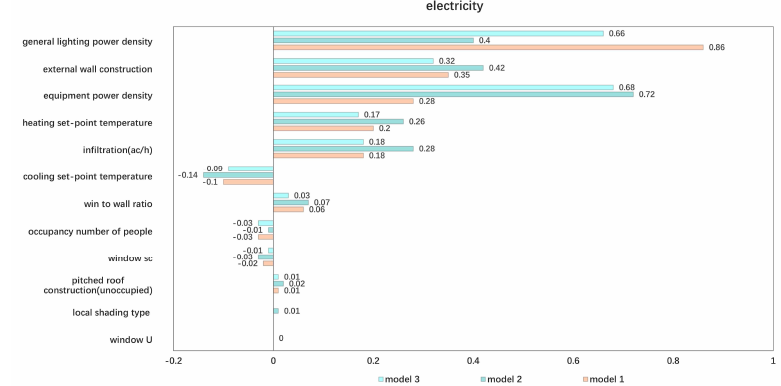
Figure 16. SRC of each parameter on electricity consumption.